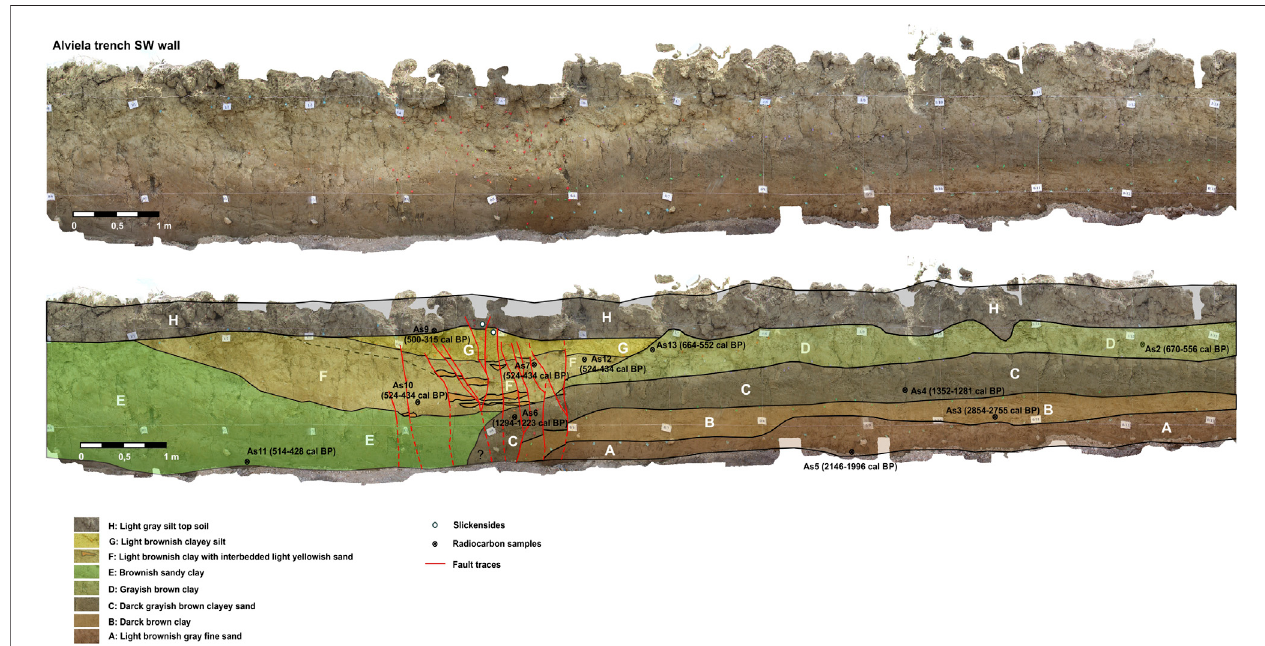
FIGURE 7 | Alviela trench SW-wall photograph (top) and corresponding log (bottom) . As2, As3, As4, As5, As6, As7, As9, As10, As11, As12 and As13 correspond to samples processed with C-14 dating. Red lines indicate the mapped traces on the trench walls, dashed when inferred.